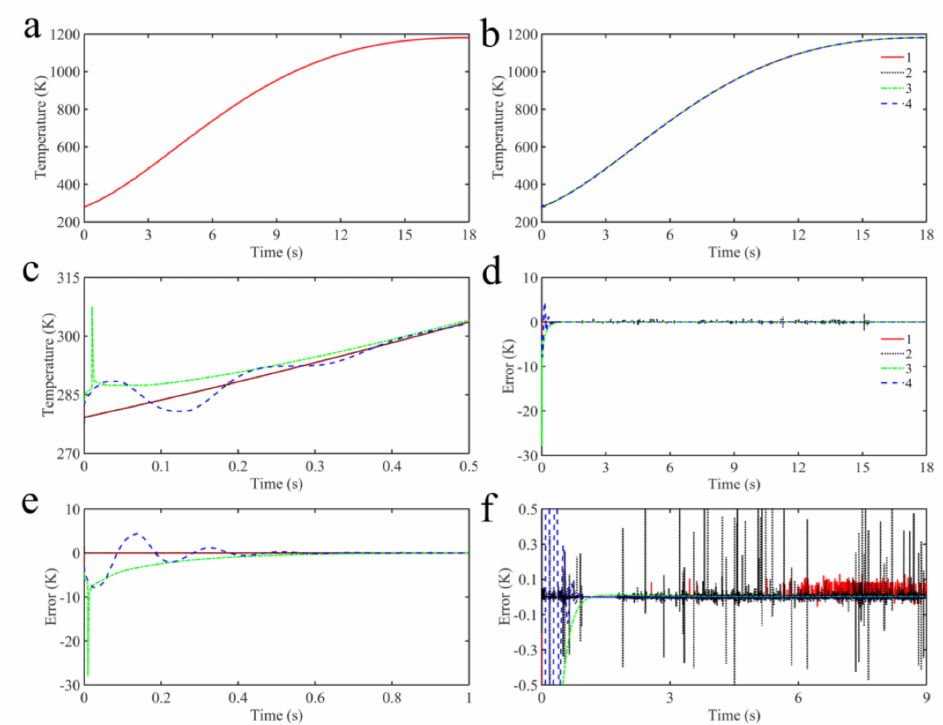
Figure 5. Simulation results without extra disturbances: ( a ) reference temperature trajectory of a hypersonic vehicle’s wing; ( b ) tracking temperature trajectory; ( c ) partial enlarged drawing of tracking temperature trajectory; ( d ) tracking errors; ( e , f ) partial enlarged drawings of tracking errors among (1) STNFOSMCTDE, (2) LFOSMC, (3) IPID and (4)